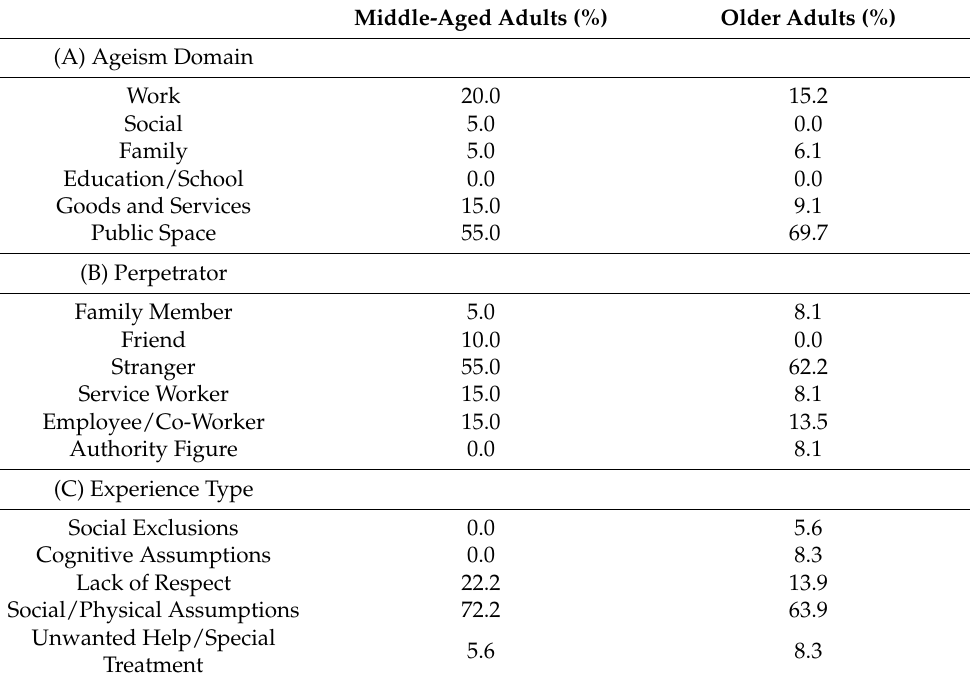
Table 1. Comparing middle-aged and older adults’ responses for (A) ageism domain, (B) perpetrator, and (C) experience